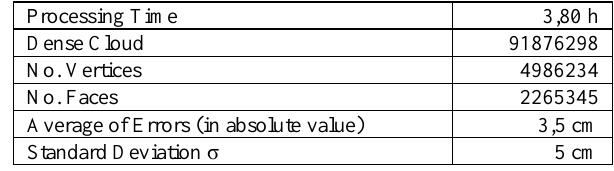
Table 2. Summary of results obtained by